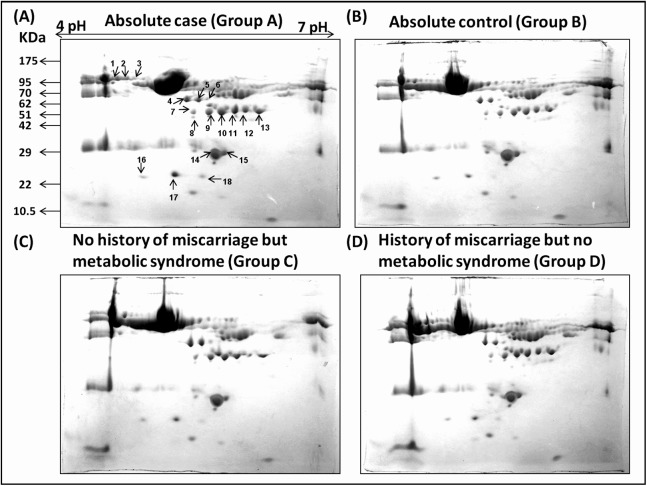
Comparative 2-DE analysis of plasma proteins.Silver stained two-Dimensional gel electrophoretic profile of plasma proteins from four different groups ((A): absolute cases with the history of miscarriage and metabolic syndrome (MeS) (Gr A); (B): absolute controls without history of miscarriage and MeS (Gr B); (C): MeS alone (Gr C); and (D): history of miscarriage alone (Gr D)). Please note the differential expression of 18 proteins among absolute cases, history of miscarriage, MeS and comparing with absolute controls. An equal amount (50 μg) of plasma proteins were separated by four to seven pH range IPG strip (seven cm) followed by SDS-PAGE (12%) and silver stained. Differentially expressed protein spots were marked with numbers.